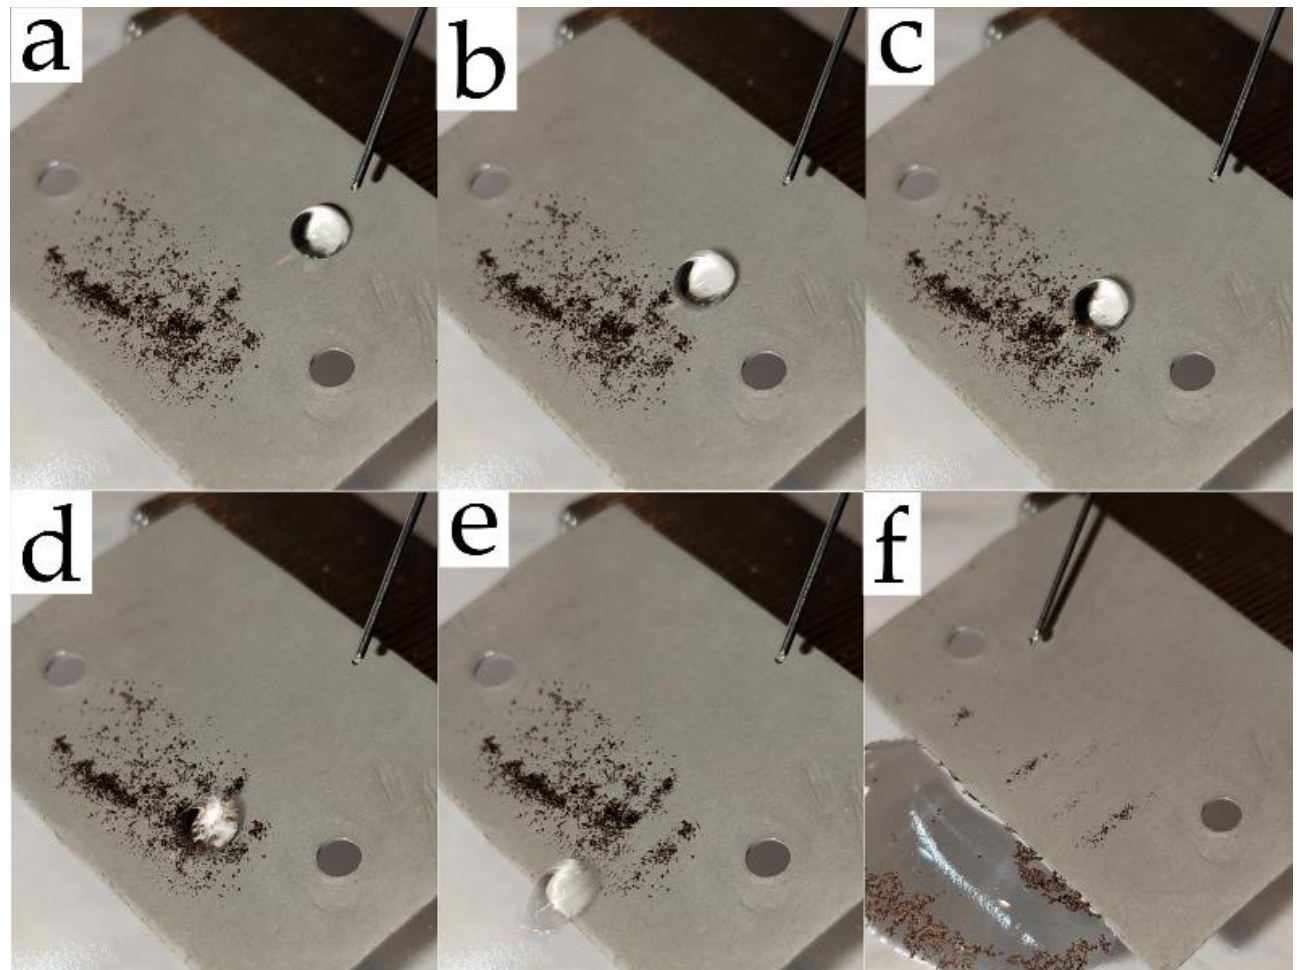
Figure 7. Self-cleaning effect due to the rolling off of a water droplet from a tilted plane (10°) of a superhydrophobic aluminum surface at various points in time: ( a ) 0; ( b ) 50; ( c ) 80; ( d ) 100; ( e ) 170 ms; ( f ) surface after rolling off of 20 water droplets.